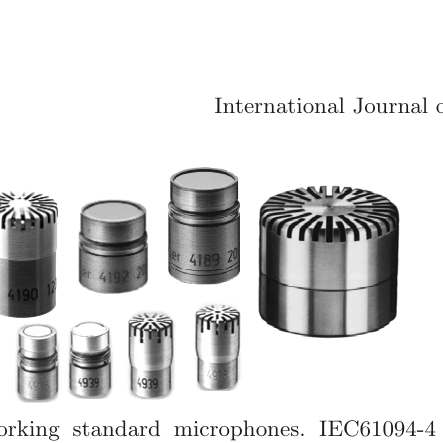
Fig. 3. Free-field, diffuse-field and pressure responses of a microphone (WS2) optimized for use in diffuse sound